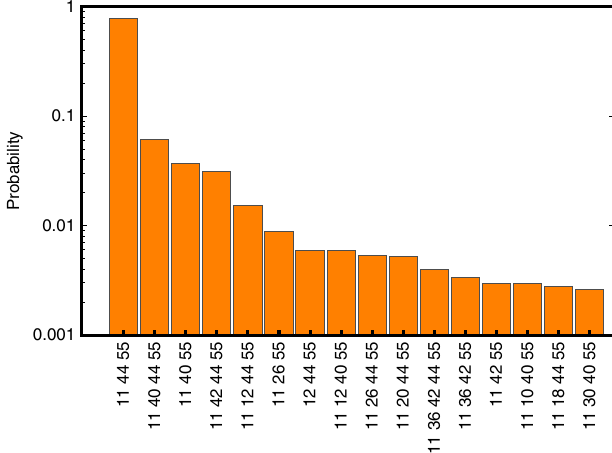
FIG. 8. The simulated distribution, at 3.5 TeV and β (cid:2) ¼ 1 . 5 m, of the most common histories of previously impacted collimators for the protons that are finally lost in a nuclear inelastic interaction on the TCTH in IR1 (55: TCTH IR1; 10 – 12: vertical, horizontal, and skew TCP in IR7; 16-44: different TCSs in IR7). For readability multiple entries of the same collimator have been neglected, e.g. particles with the history (11,11,44,55), where the two hits on collimator 11 occur on different turns, are counted in the same bin as